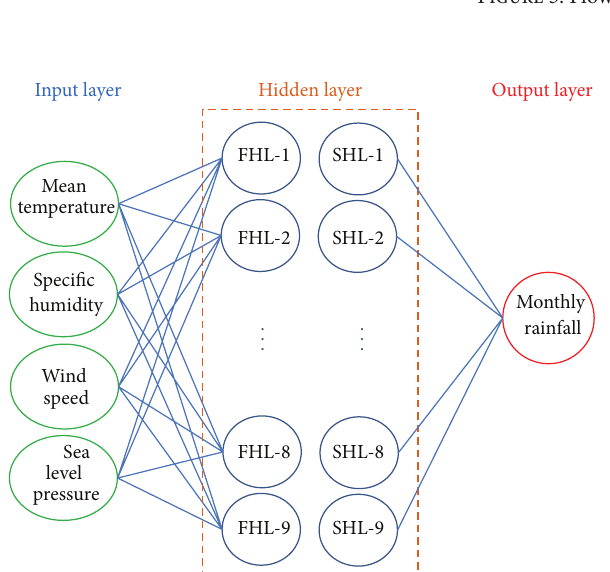
between 0.62 and 0.86. The residuals of rainfall in each weather station were calculated using this primary regression relationship, and the SKlm technique was